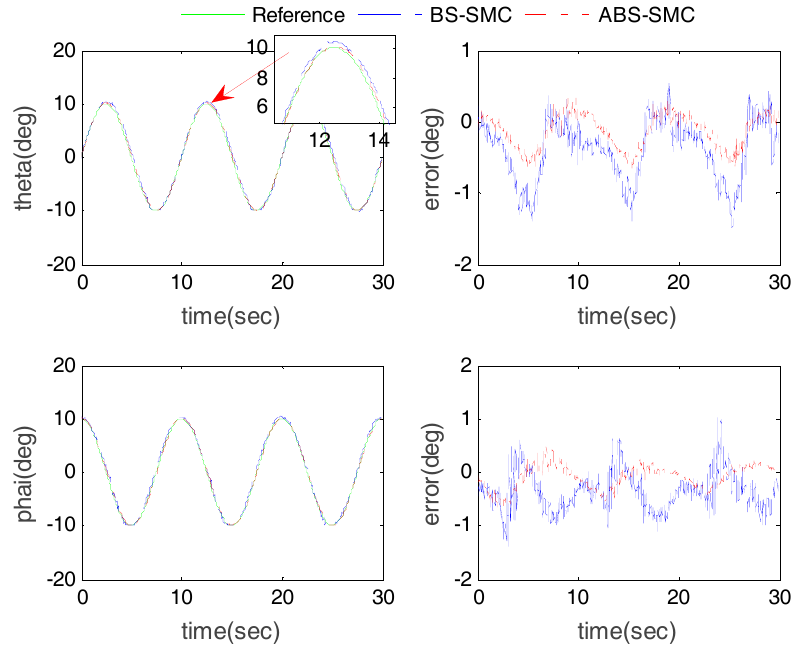
Figure 7. Robot end-effector angle tracking results (without subject). Table 1. Statistical analysis of actuator position tracking errors under different control methods (without subject).